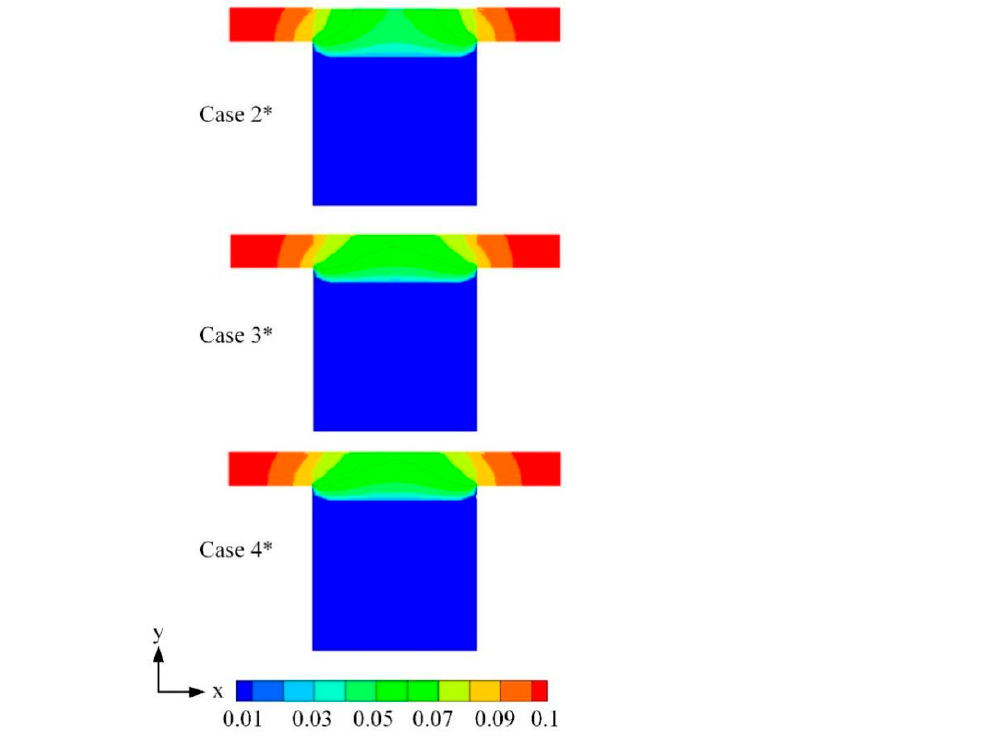
Figure 12. Distribution of the volume fraction distribution of liquid water in the cathode channel cross sectional plane near the cathode inlet (z = 5 mm) when the operating voltage is 0.6 V in Case 2*, Case 3* and Case 4*.